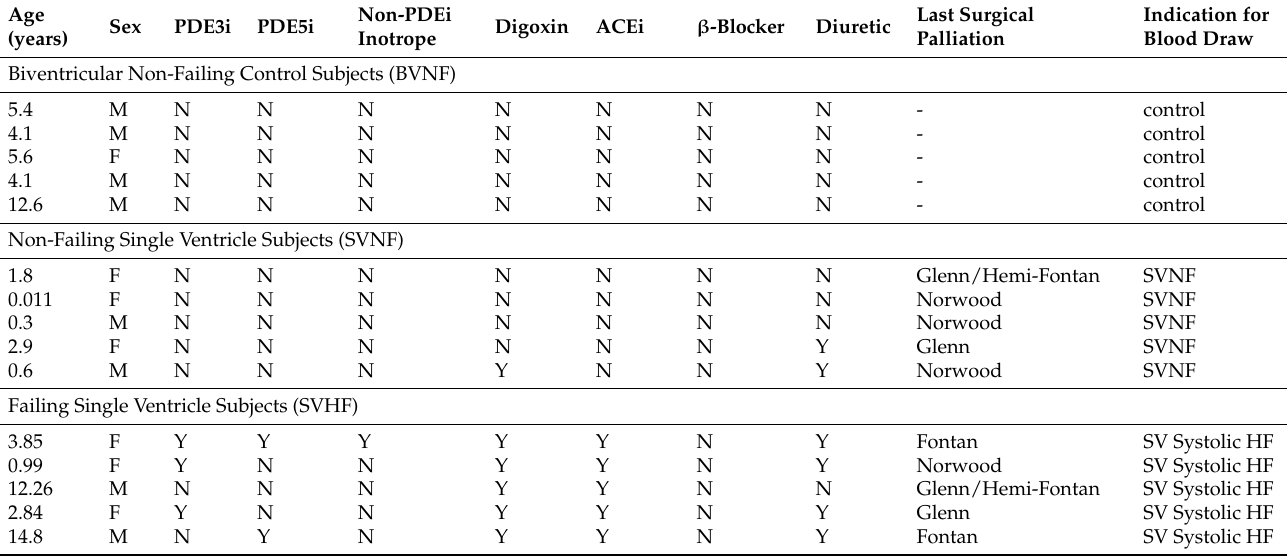
Table 1. Patient